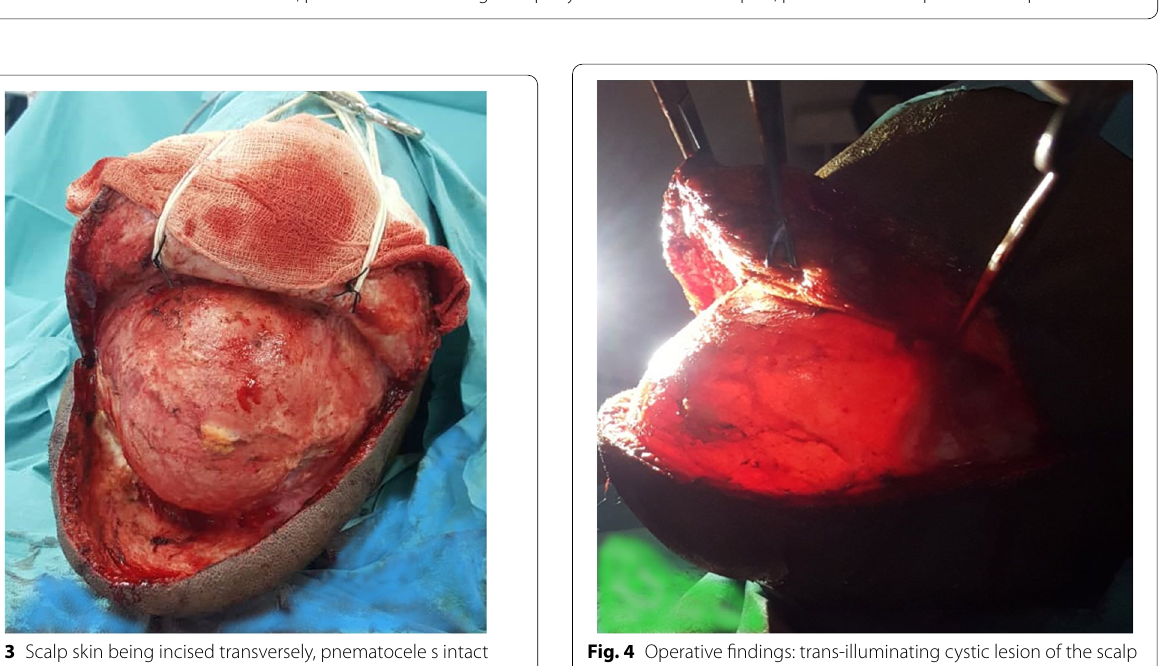
Fig. 2 A CT scan axial cut, bone window, demonstrating, extradural pnemocephalus (red arrow), pneumatocele (green arrow), and lytic skull defects of the occipital bone. B Sagittal MRI T1 weighted, demonstrating huge parietal and occipital pneumocephalus (red arrow) communicating with the pneumatocele (green arrow). Intact dura is demonstrated (blue arrow) and soft tissue trabeculae (yellow arrow) is identified communicating bone defects with the scalp. C MRV study showing multiple branches and net of vessels draining blood from the mass bulge (pneumatocele) toward the superior sinuses. D 3D CT scan of the skull, posterior view showing multiple lytic lesions of the occipital, parietal and left squamous temporal bones